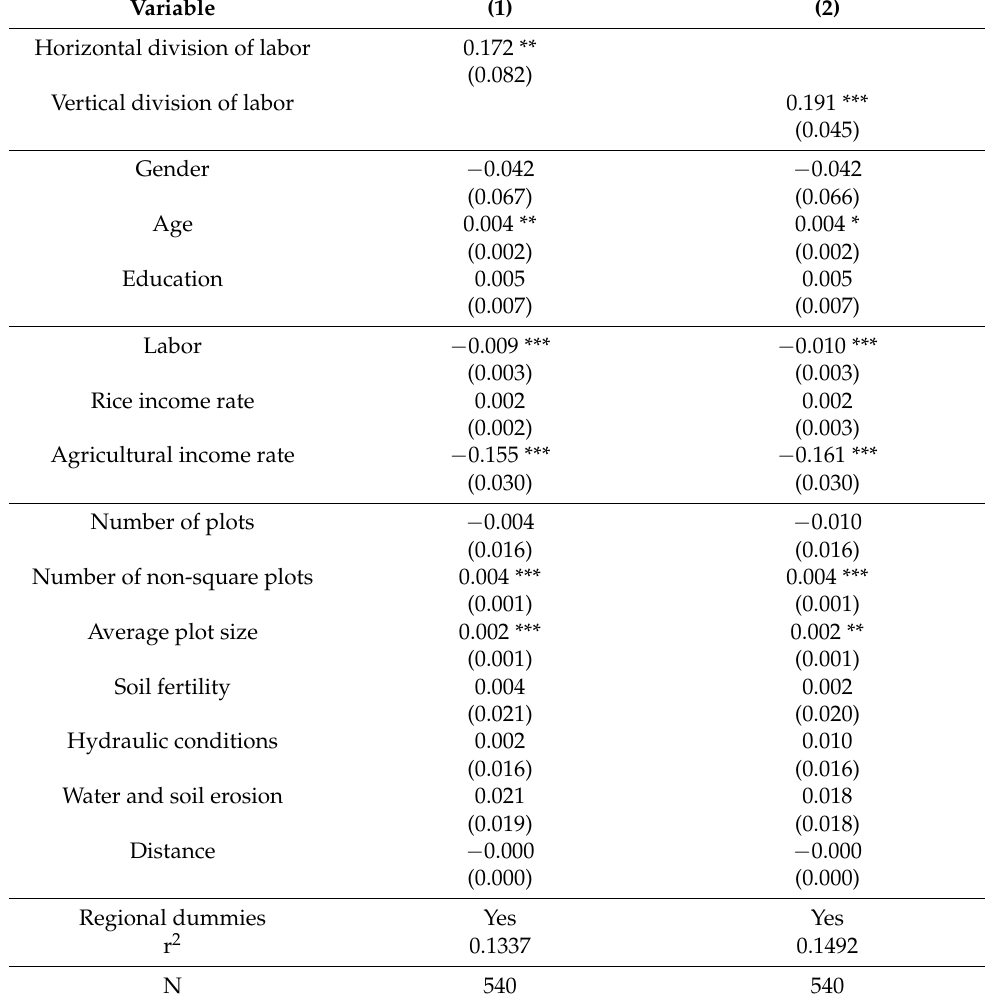
Table 3. Regression results of the effect of agricultural division of labor on fertilizer reduction